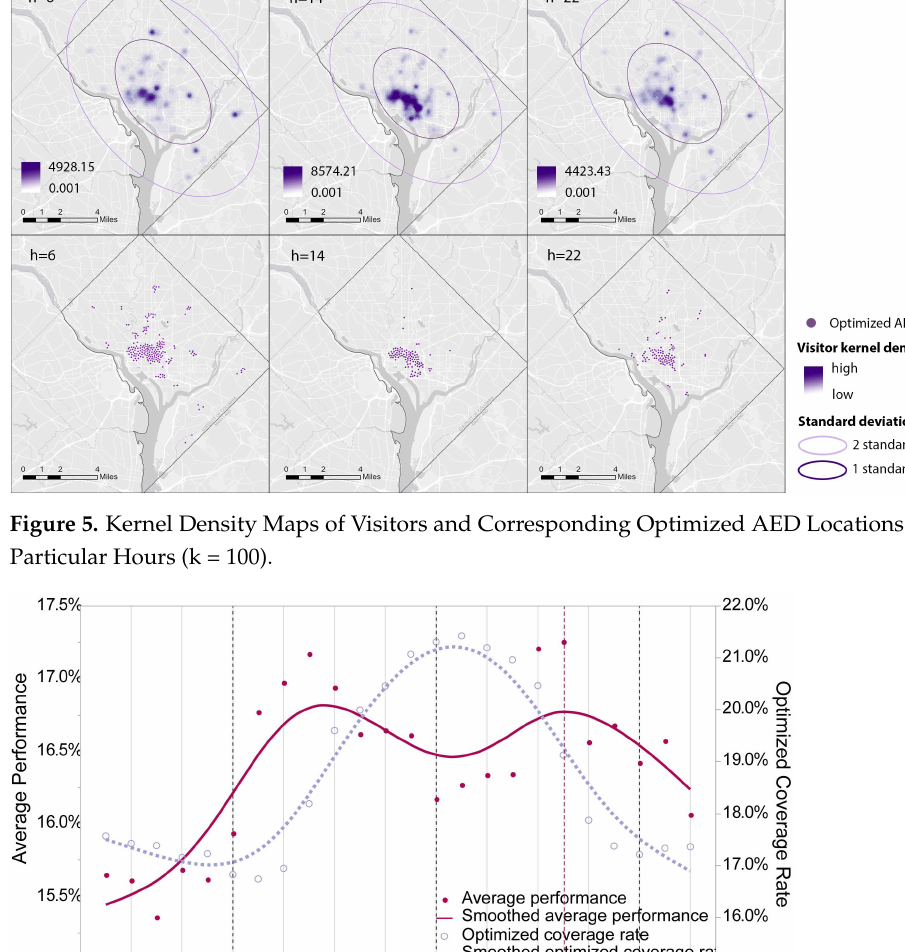
Figure 4. Optimized AED coverage rate. The optimized AED coverage rate ( R J (cid:48) coverage rate using the set of optimized AEDs in a specific hour to cover the visitor distribution of the hour itself. For each hour, the error bar is generated from resampling 61,575 visitors from the total number of visitors 100 times.